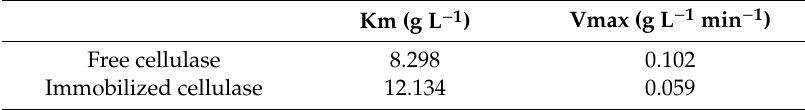
Figure 10. Effect of recycling on the glucose productivity of immobilized cellulase. Each cycle was performed at pH 4 and 60 °C for 24 h.